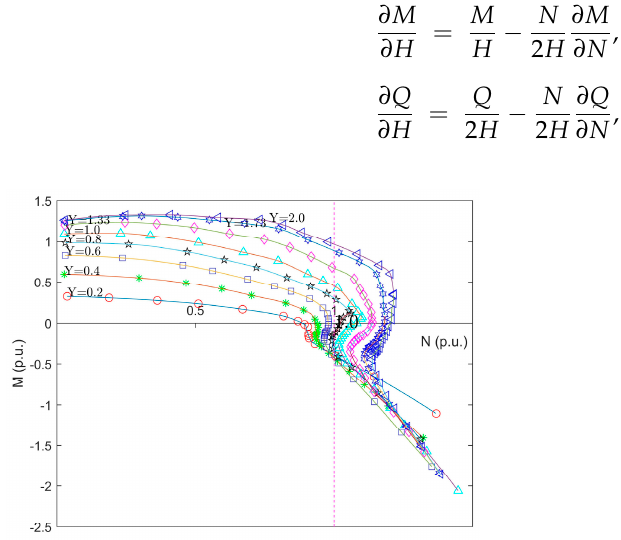
Figure 3. N–M standard characteristic curve of pump–turbine.